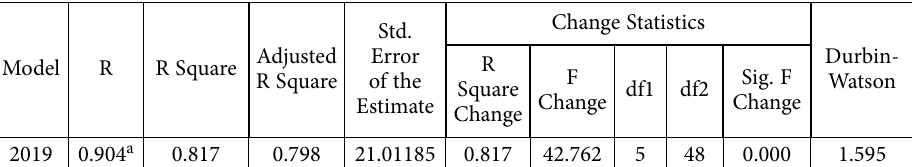
Change Statistics